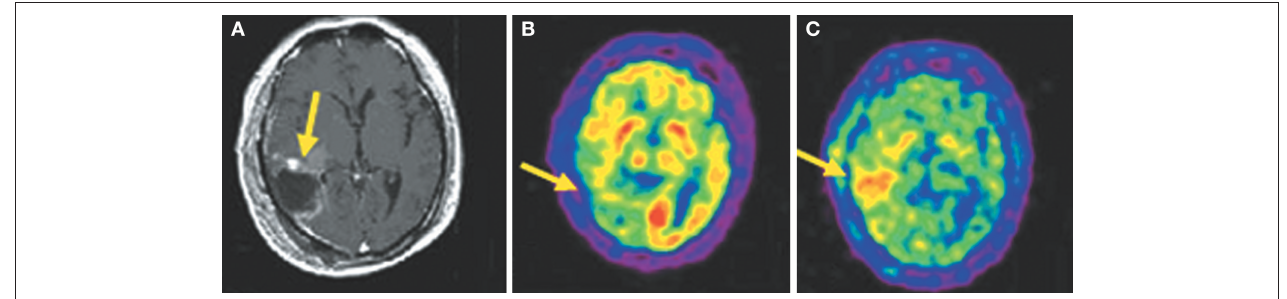
FIGURE 3 | Images (Axial) of a 45-year-old man with a history of attempted resection of World Health Organization (WHO) grade glioma. (A) Subsequent new abnormal enhancing lesion (arrow) on Magnetic resonance (MRI). (B) 18 F-FDG PET imaging illustrated patching-shaped hypormetabolism in the right temporal lobe (arrow). (C) 11 C-MCYS PET imaging showed a patching-shaped hyperrmetabolism lesion (arrow), which was predominant high-grade tumor recurrence confirmed on histopathology. This figure is reproduced with permission from Deng et al. (2011), Figure 5 © by the Society of Journal of Nuclear Medicine Imaging, Inc.